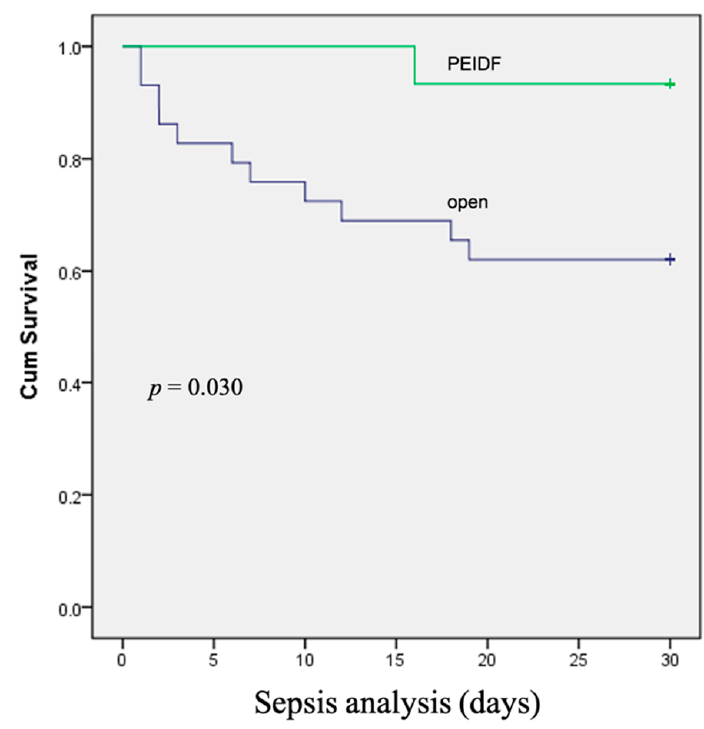
Figure 3. The Kaplan–Meier curve shows that patients receiving conventional open surgery had a higher rate of sepsis within one month after surgery.